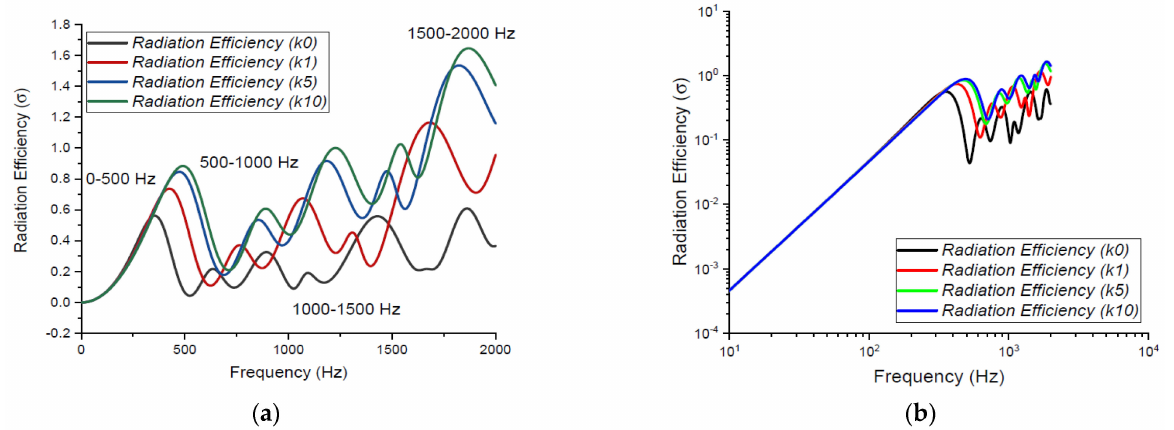
Figure 13. Variation of radiation efficiency with power-law indexes, k: ( a ) normal and ( b ) log-log scale.